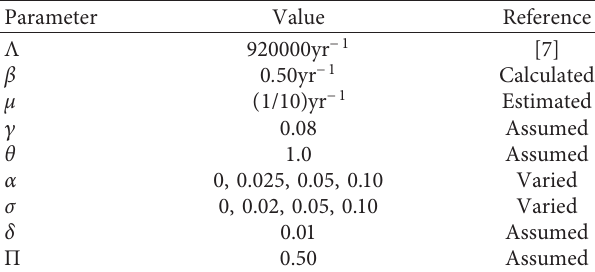
Table 2: Baseline values for parameters of system (1).